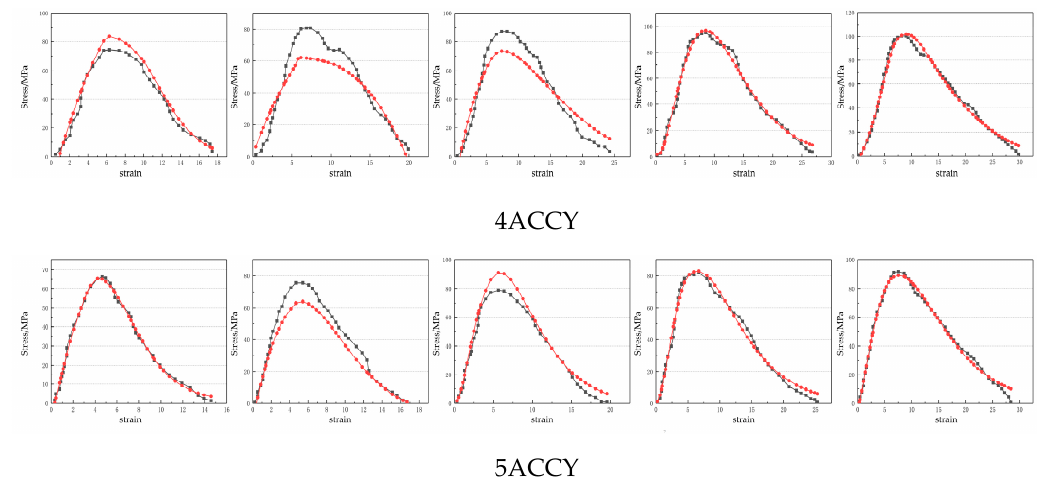
Figure 10. Comparison of optimization effects of impact compression model.